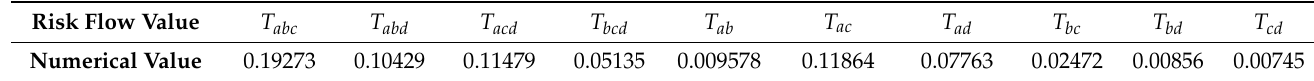
Table 6. Risk coupling flow